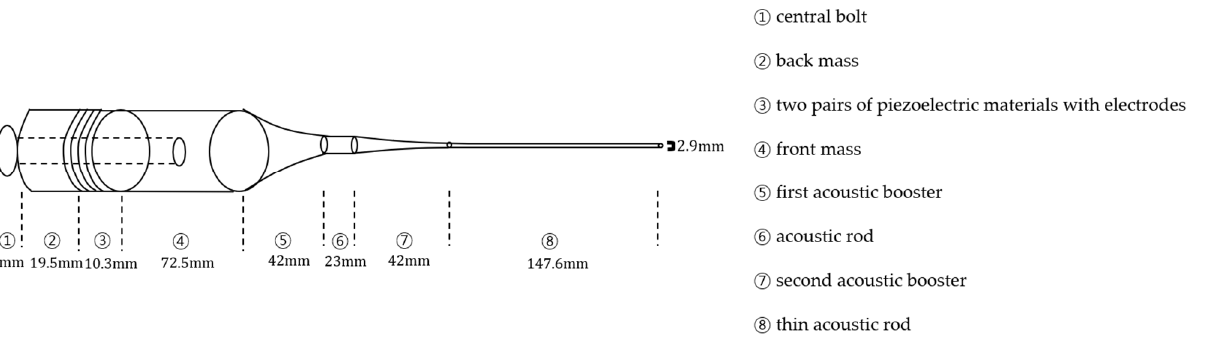
Figure 1. Illustration of Langevin transducer.